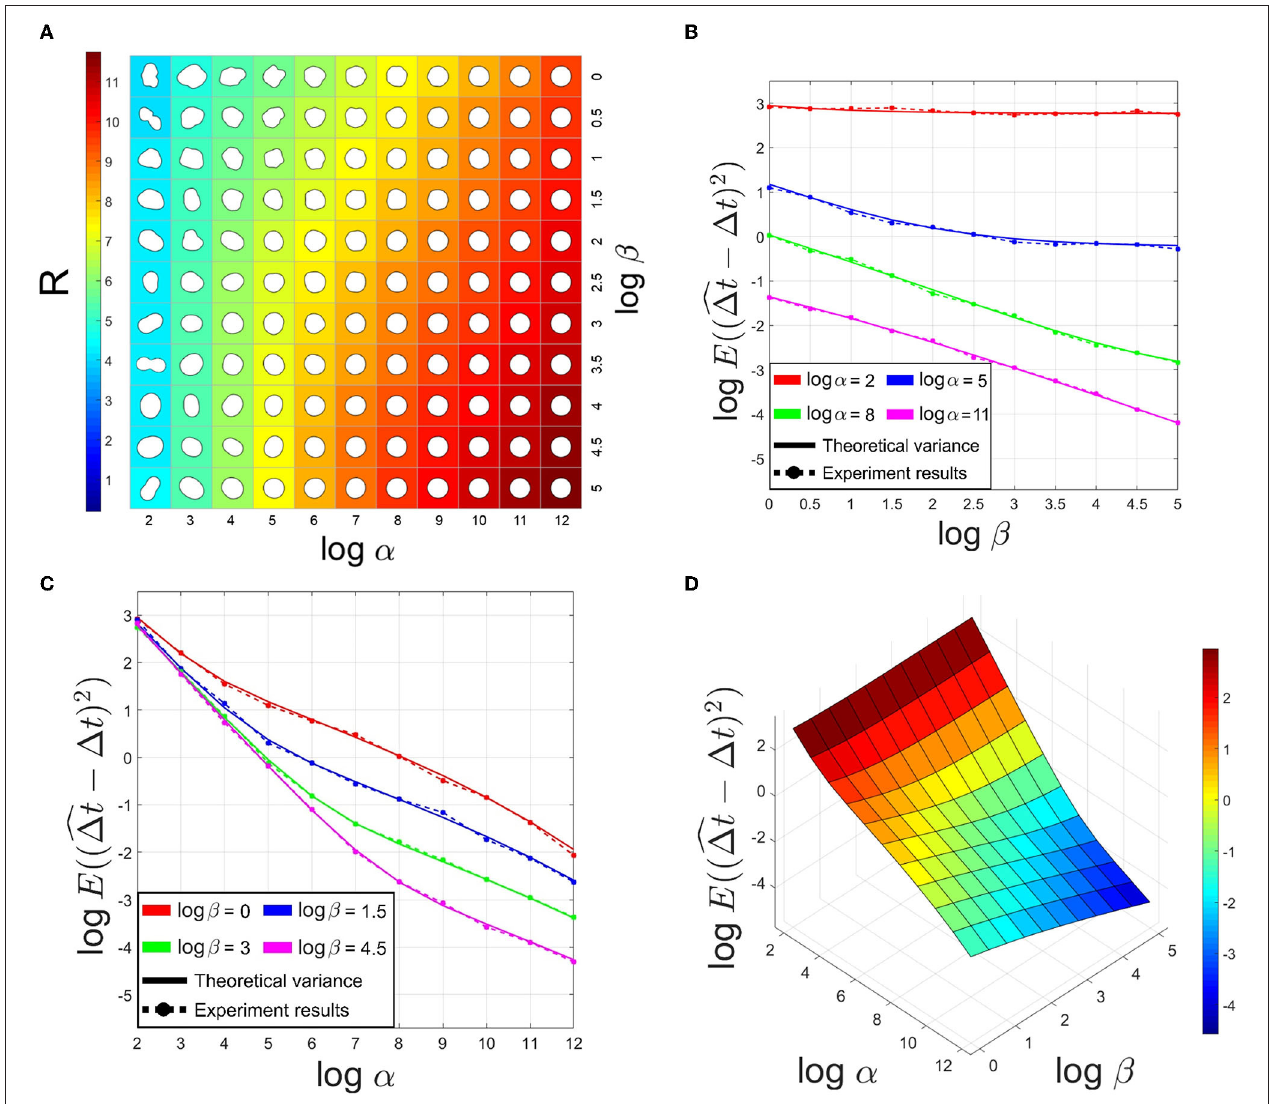
FIGURE 2 | (A) Simulated projections of the spherical deformation model with p Comparison of theoretical variance and experiment results of estimated translation in X-axis on synthetic datasets. (D) The theoretical variance of estimated translation with p 4 and changing α and β =